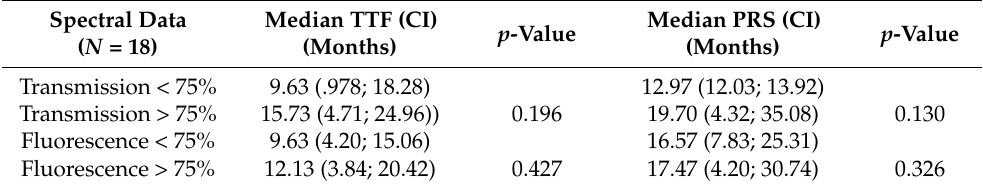
Table 5. Results of statistical tests of the association of intraoperative spectral online monitoring with time-to-treatment failure (TTF) and post-recurrence survival (PRS), including 95% confidence intervals